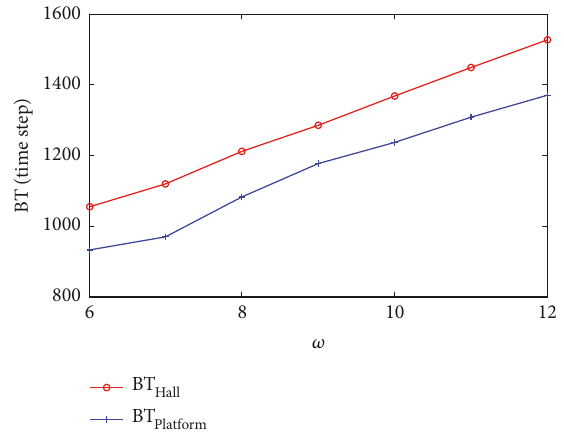
Figure 3: The boarding time at the waiting hall and platform.